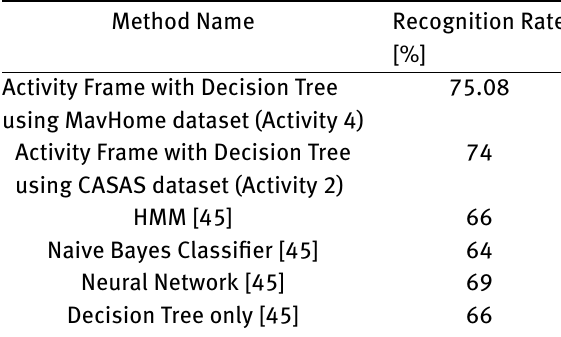
Table 8: Recognition rate using similar methods for the activity cook and preparing breakfast (one week